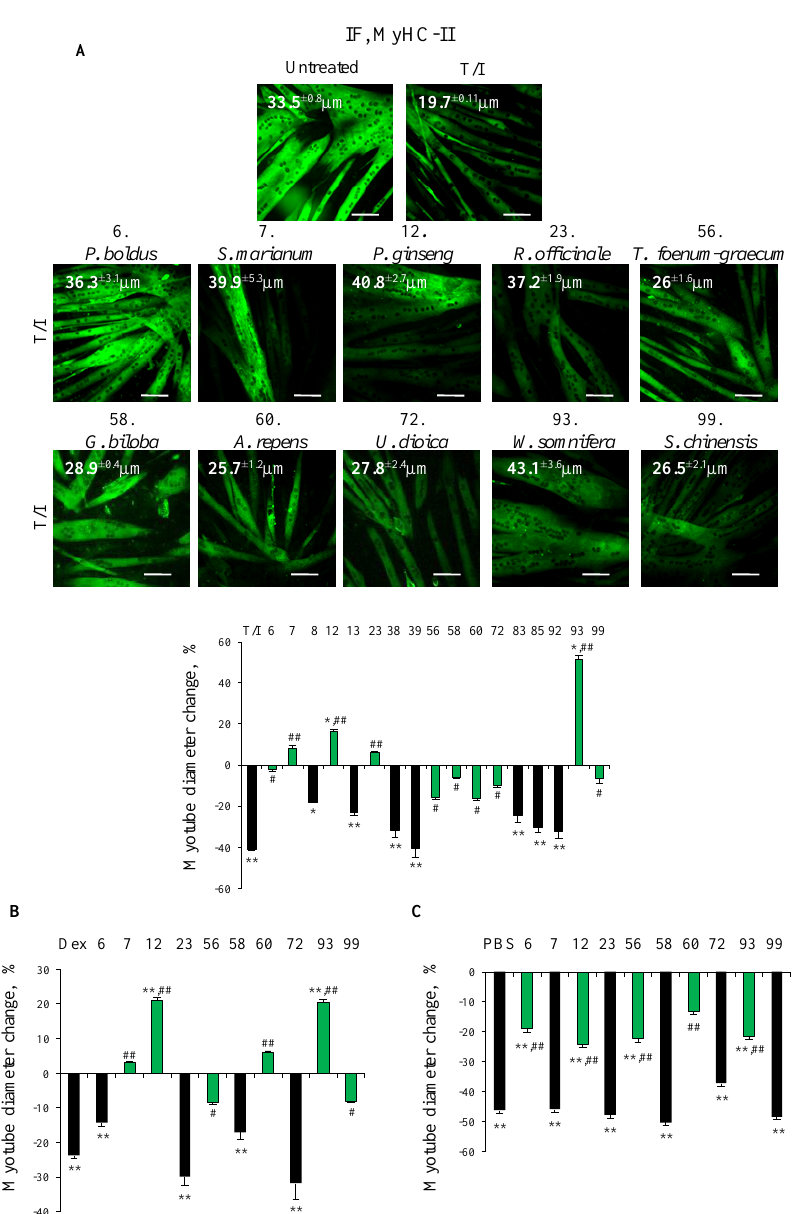
Figure 1. ( A – C ) C2C12 myotubes were treated or not with TNF α (tumor necrosis factor α , 20 ng/mL)/IFN γ (interferon γ , 100 U/mL) (T/I), dexamethasone (Dex, 1 µ M) or starved with PBS (phosphate buffered saline) in the absence or presence of each selected plant extracts for different times. Immunofluorescence (IF) analysis for myosin heavy chain (MyHC)-II was performed after 48 h or 16 h (PBS), and myotube diameters were measured by Image J software. Reported are representative images with myotube diameters ( µ m) ( A ) and the percentages of myotube diameters with respect to untreated control ( A – C ). The green bars represent the extracts able to protect against myotube atrophy induced by different stimuli. Results are means ± SEM (standard error of the mean) ( A – C ). Statistical analysis was conducted using t -test * p < 0.05, ** p < 0.01 significantly different from untreated control; # p < 0.05 and ## p < 0.01 significantly different from T/I, Dex or PBS. Bars, 100 µ m. In conclusion, ten plant extracts appeared able to abolish/reduce the myotube atrophy induced by inflammatory cytokines, and underwent for further investigation.